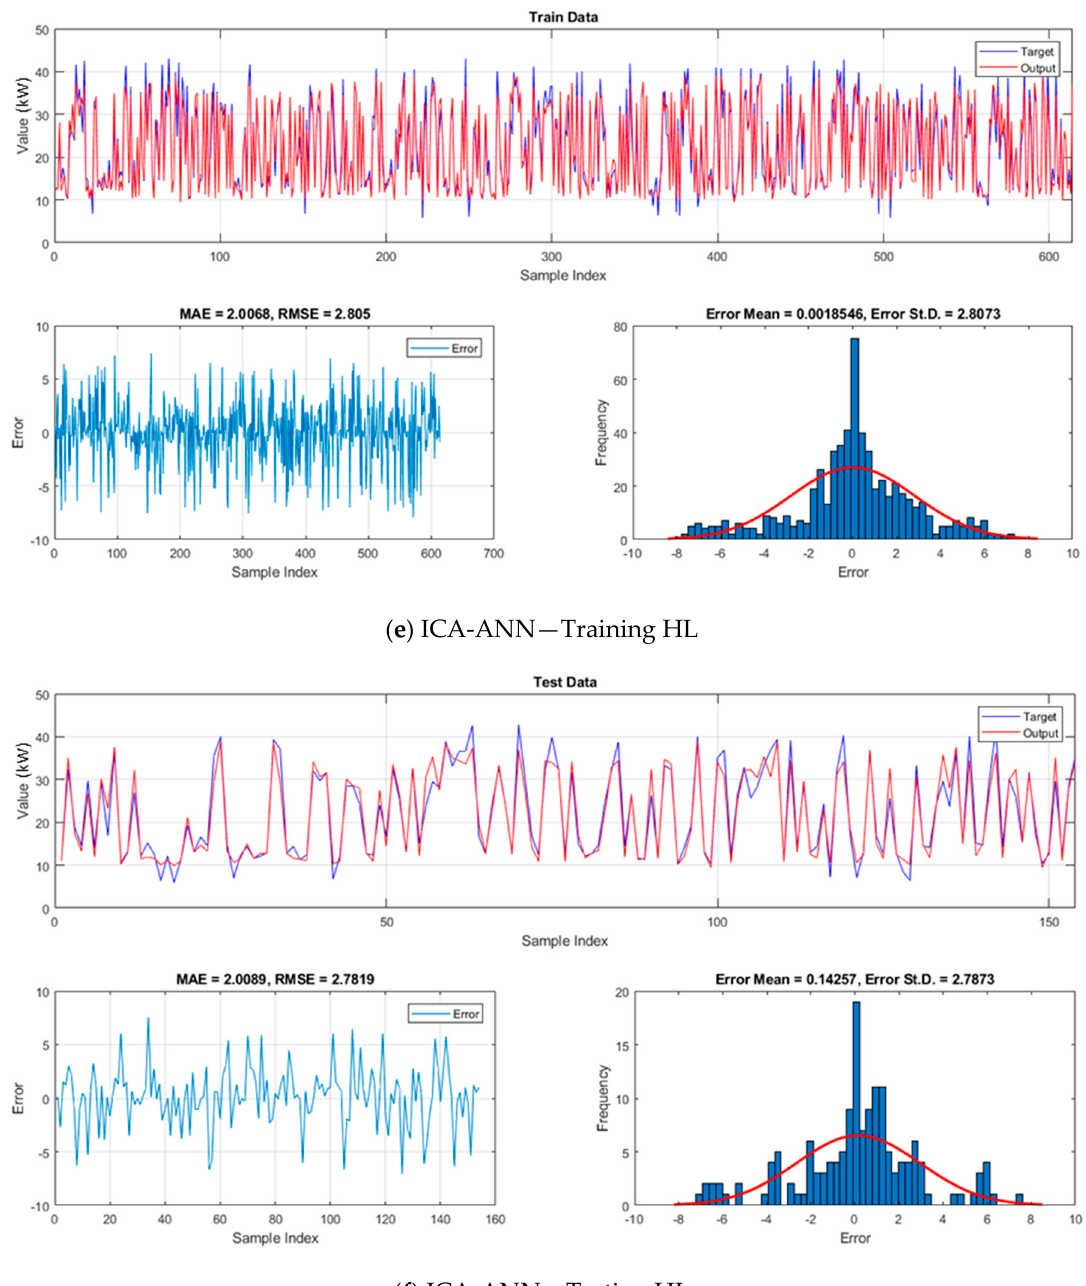
Figure 11. A graphical view of the obtained results and the calculated errors for HL prediction.